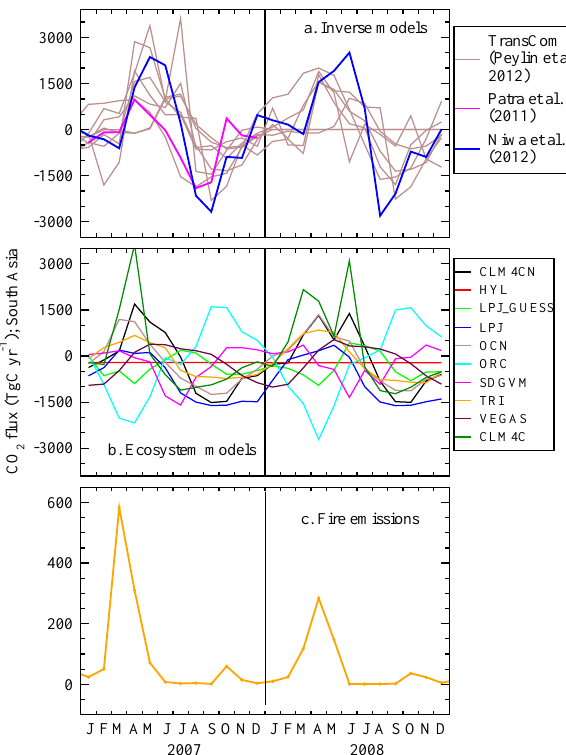
Fig. 3. Seasonal cycles of South Asian fluxes (TgCyr − 1 ) as simu- lated by atmospheric inversions ( a , top panel), terrestrial ecosystem Fig.3. SeasonalcyclesofSouthAsianfluxes( TgCyr − 1 )assimulatedbyatmosphericinversions( a ,toppanel),terrestrialecosystemmodels ( b , middle panel) and fire emissions modeling ( c , bottom panel). models ( b , middle panel) and fire emissions modeling ( c , bottom panel).